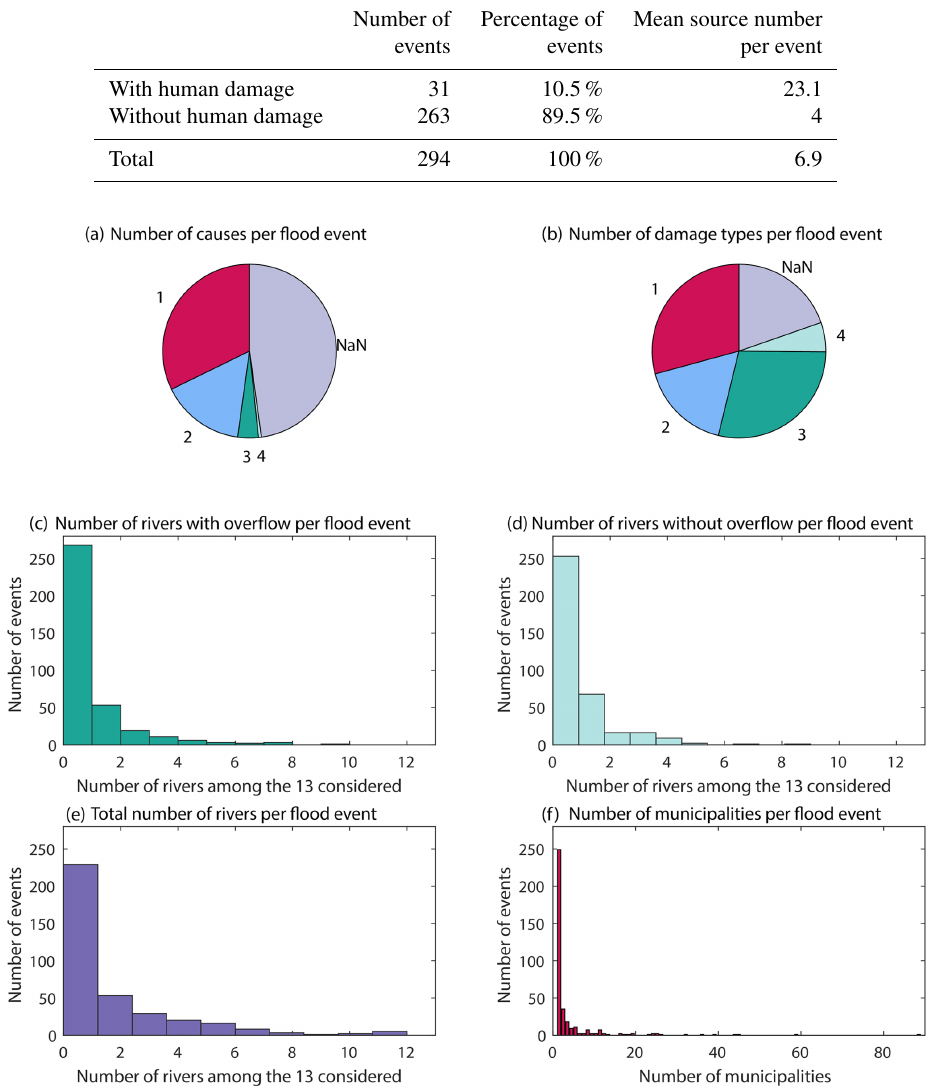
Figure 7. Characterization of the interannual distribution of events. (a) Number of documented causes. (b) Number of documented damage types; number of rivers per event among the 13 rivers studied (c) with water overflow, (d) without water overflow, and (e) with and without water overflow. (f) Number of impacted municipalities, whereby only those where water overflow has been reported are